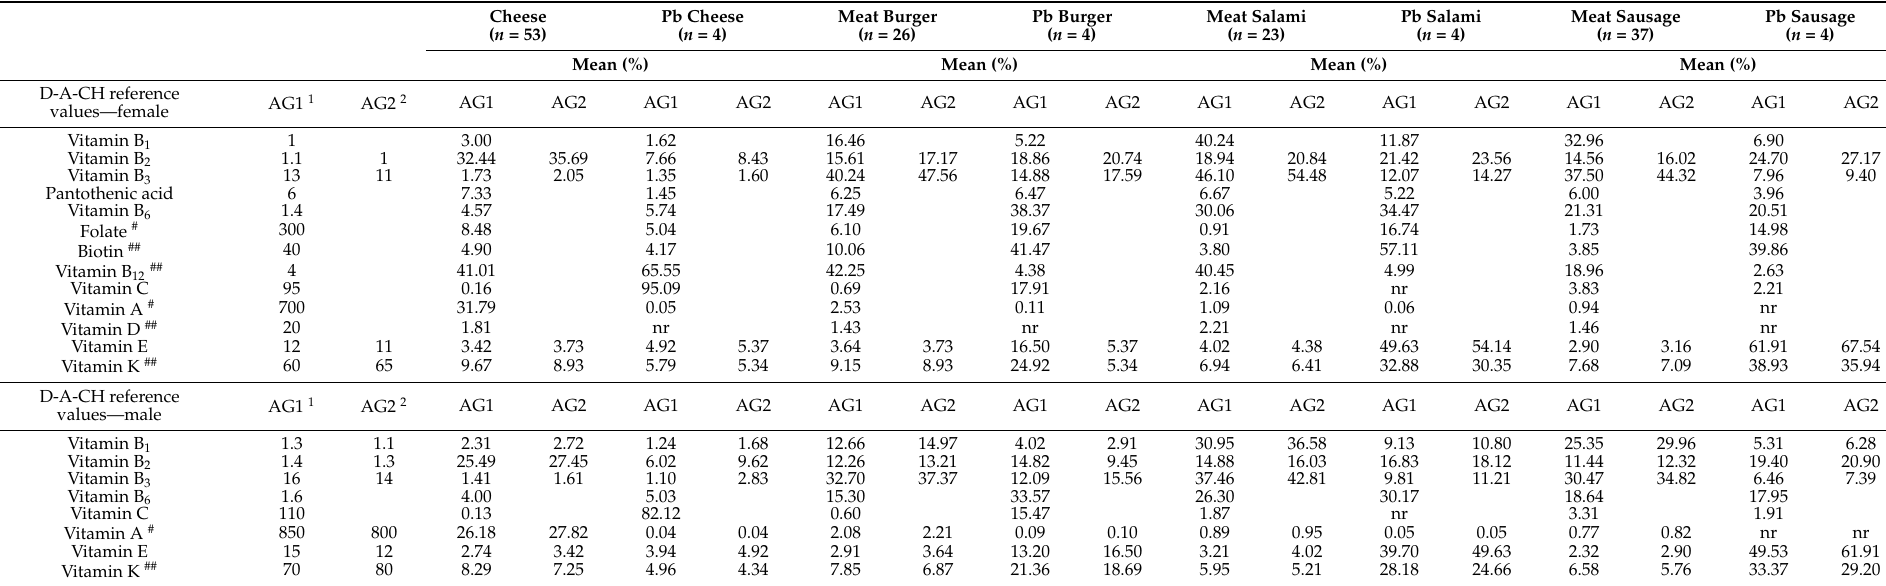
Table 8. Coverage of the daily vitamin requirements by pb alternative products compared to animal-based products *. Percentage related to the recommendations of the D-A-CH reference values, given in mg #, ## per 100 g of foods, and related to gender and age groups (19–25 Y (years) and ≥ 65